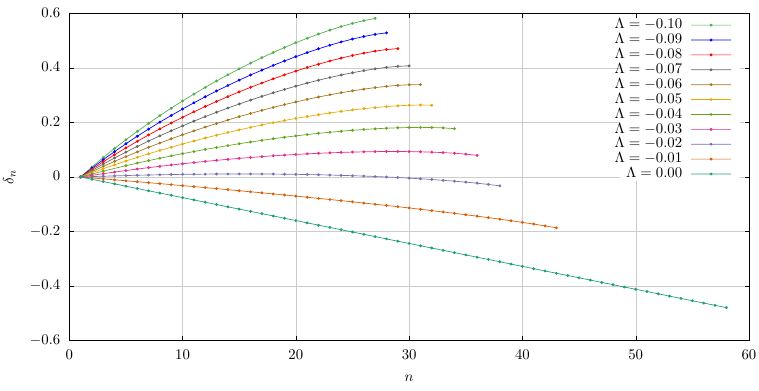
Figure 12 . The relative excess energies for the allowed values of the topological charge for the old baby potential for di(cid:11)erent values of (cid:3). Here (cid:21) = (cid:22) = 1 and (cid:20) 2 = 0 :